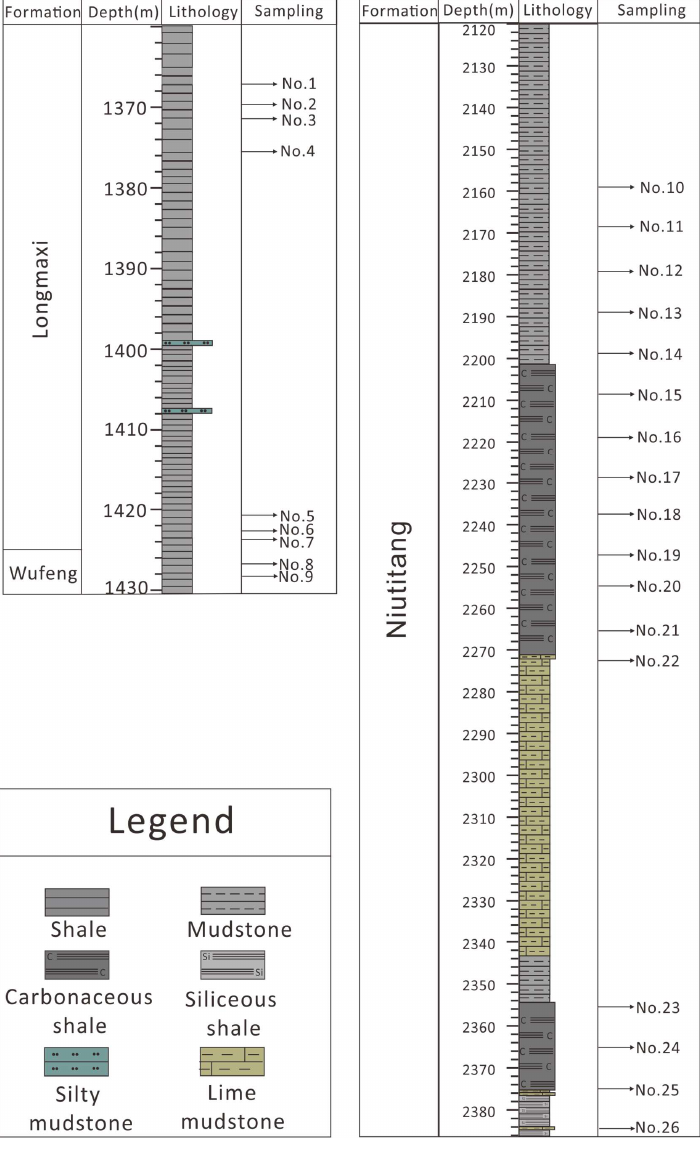
Figure 2. Stratigraphic sequences and the sampling depths of the Wufeng-Longmaxi Formation and the Niutitang Formation.